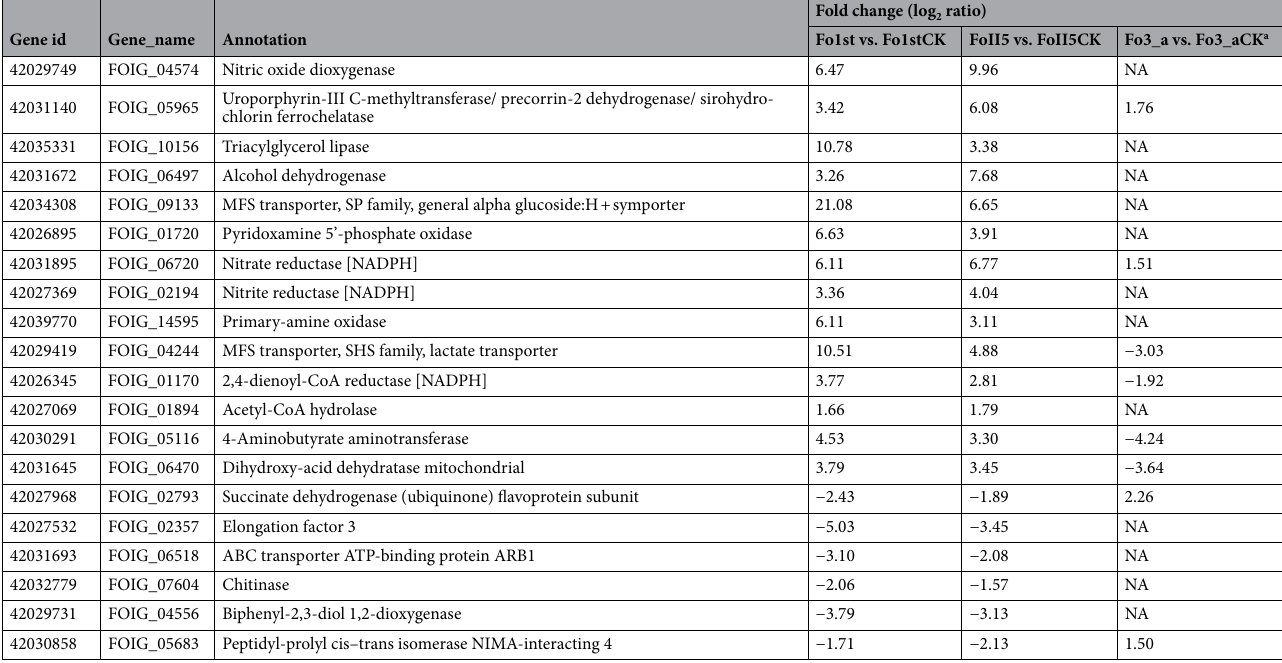
Table 4. The DEGs involved in resistance regulation of phenamacril in Fo. a NA represents no significant difference or no expression level of genes was detected. The fold change value is represented by the log2 ratio. ‘CK’ represents the control groups treated with 0.1 μL/mL methanol and others represent the treatment groups treated with 1 μg/mL